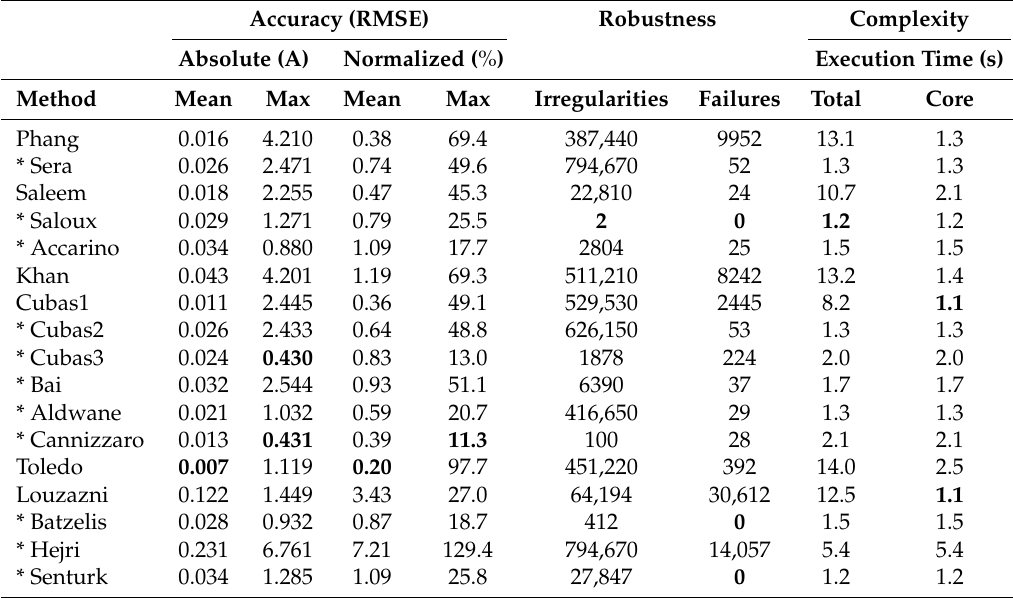
Table 3. Performance of all 17 parameters extraction